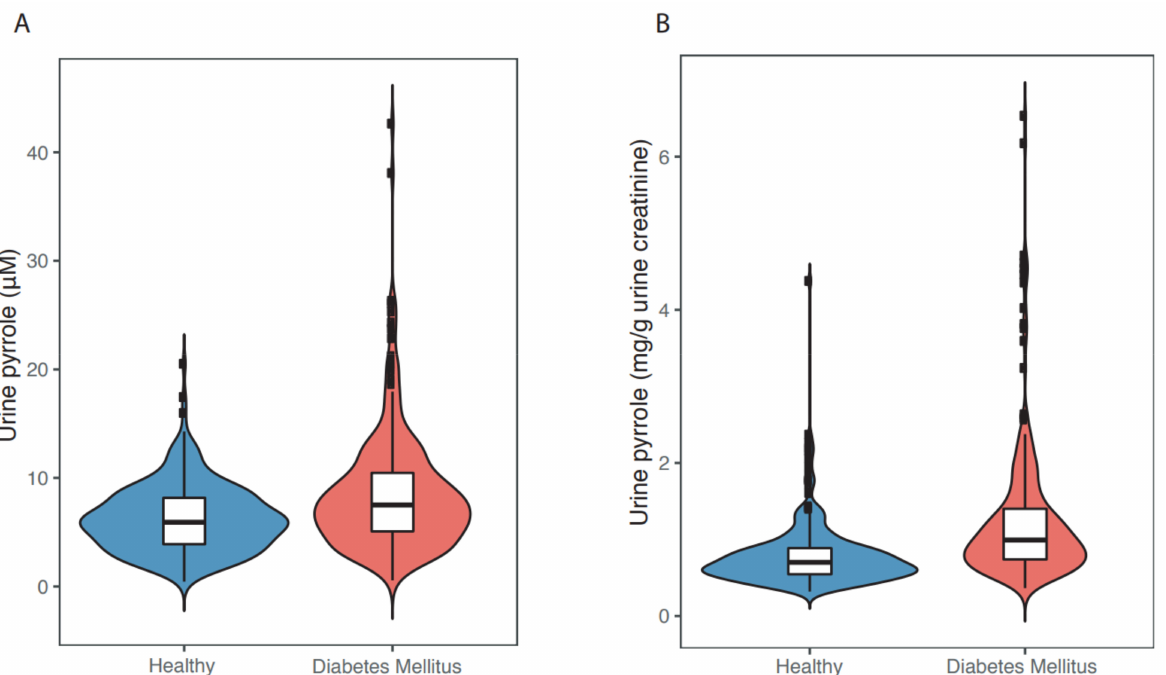
Figure 5. Violin plots of the distribution of urinary γ -diketone pyrrole adducts before ( A ) and after ( B ) correction for urinary creatinine, the excreted metabolite of muscle creatine. The white box in the center represents the interquartile range and the center line in the middle represents the median value. The thin black line extended from the thick black bar represents the upper (max) and lower (min) adjacent values of the data. (Figure 5A was redrawn from